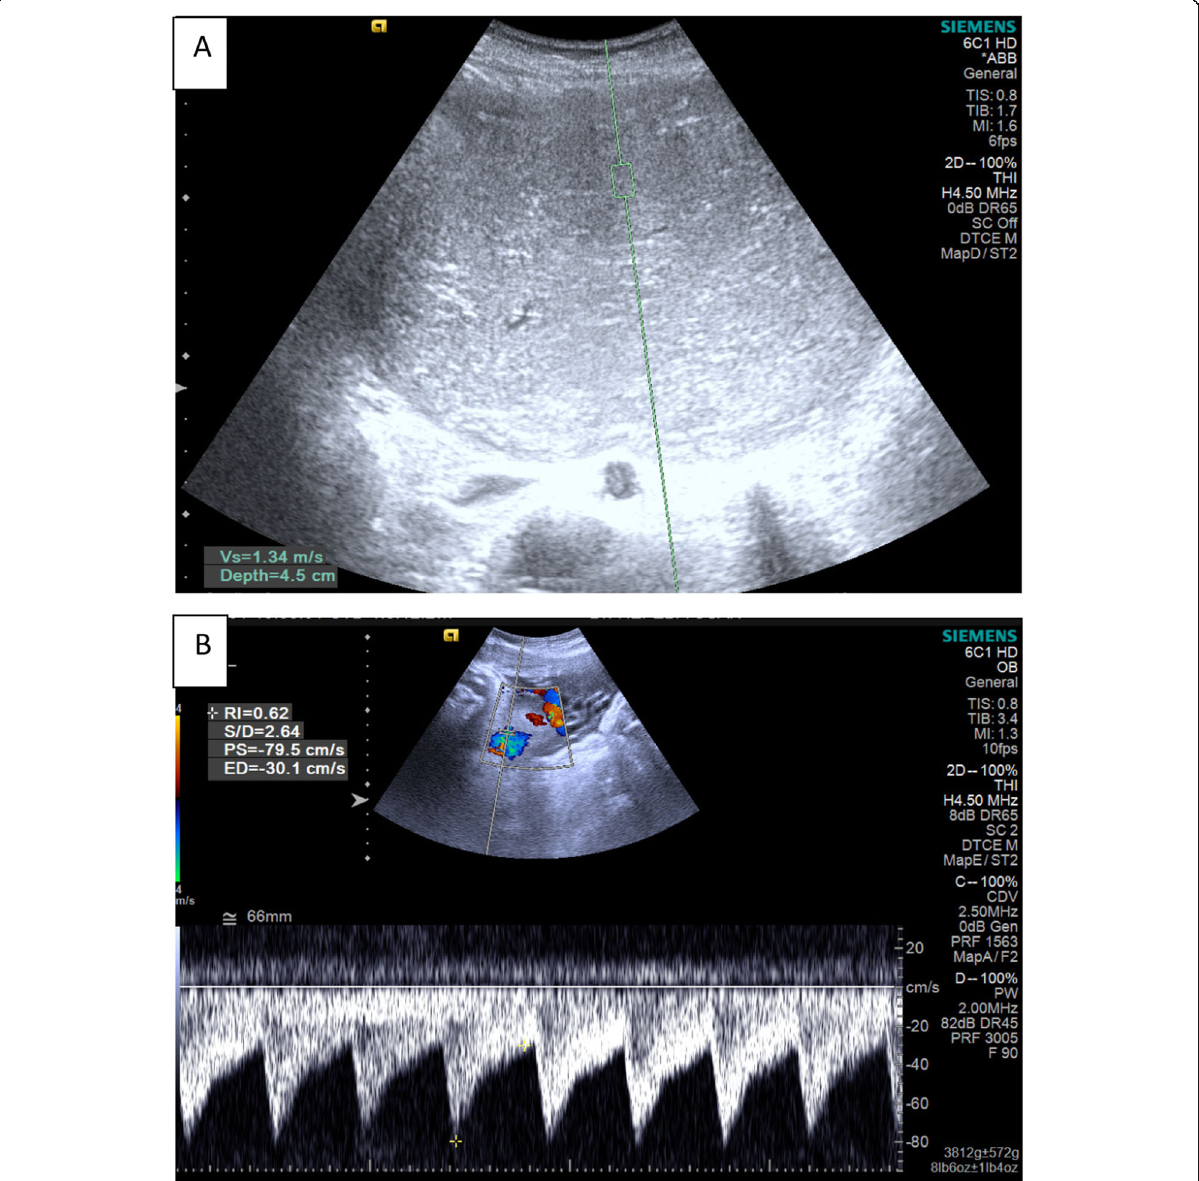
Fig. 4 Pregnancy with diabetes and macrosomia, gestational age 35 weeks, and estimated fetal. Weight 4.2 kg. a SWV = 1.34 m/s, depth 4.5 cm. b Normal flow in the umbilical artery. In the current, the pregnancies with diabetes showed only mild increased elasticity in the third